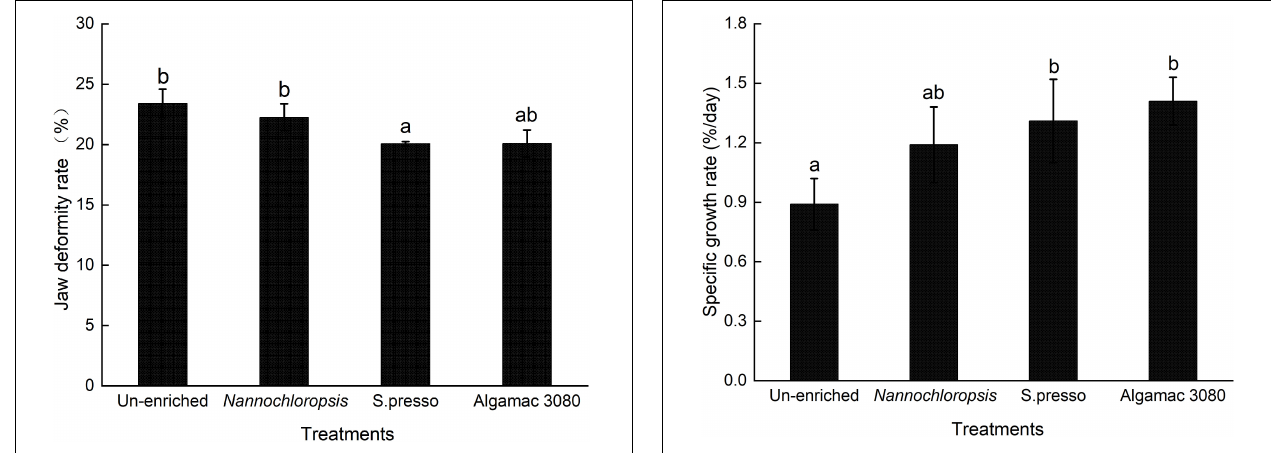
FIGURE 2 | Specific growth rate of golden pompano larvae in four treatments.